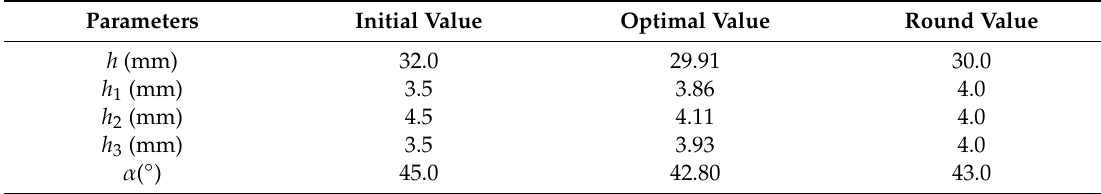
Table 3. The results of size